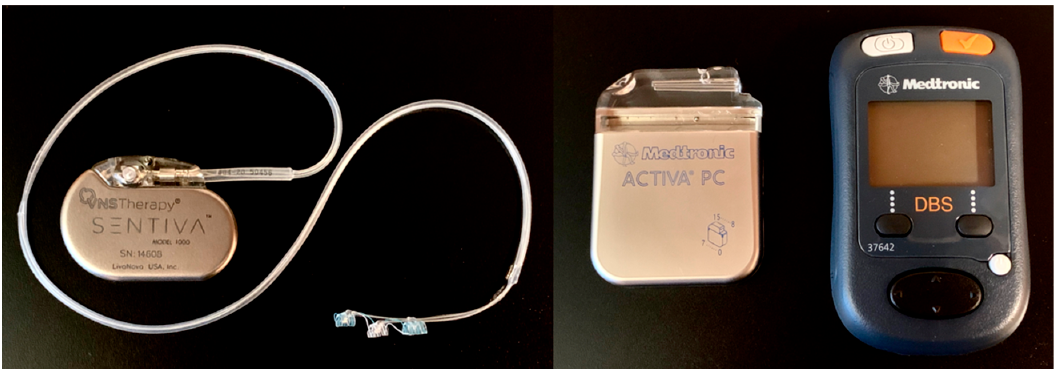
Figure 1. Examples of vagus nerve stimulation (VNS) and deep brain stimulation (DBS) devices. VNS internal pulse generator or neurostimulator (left side of left panel) with extension and coil electrodes (right side of left panel). DBS neurostimulator (left side of right panel) and patient programmer (right side of right panel).